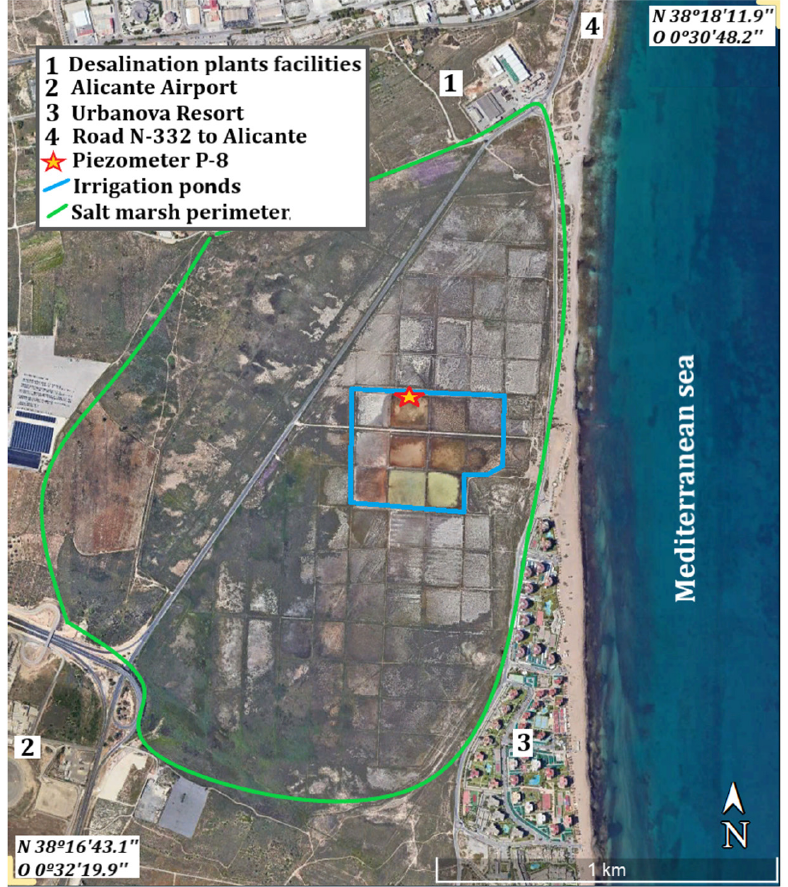
Figure 1. The Agua Amarga salt marsh and the seawater irrigation area. Geographic coordinates are in the corner (Base image from Google Earth [California, USA], Landsat Copernicus [USA], and Maxar Technologies [Colorado, USA]).